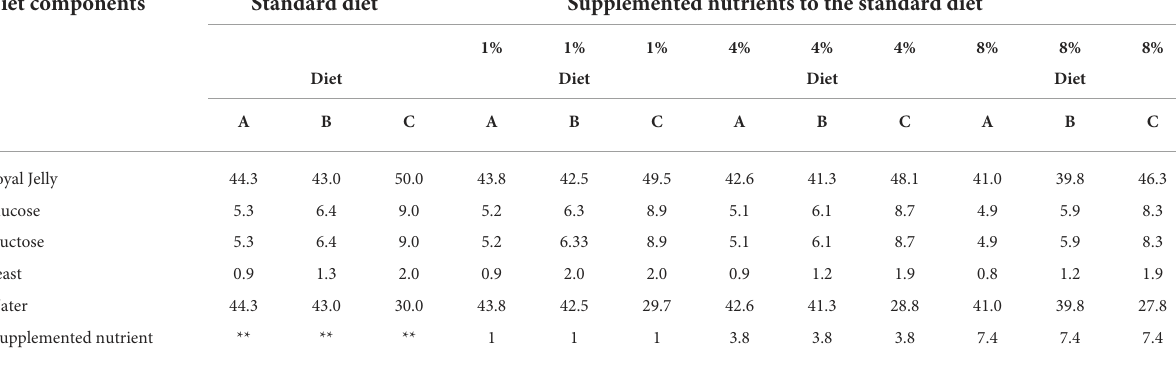
TABLE 1 The percentage of diet components of the standard diet and different percentages of supplemented nutrients added to the standard diet. Diet